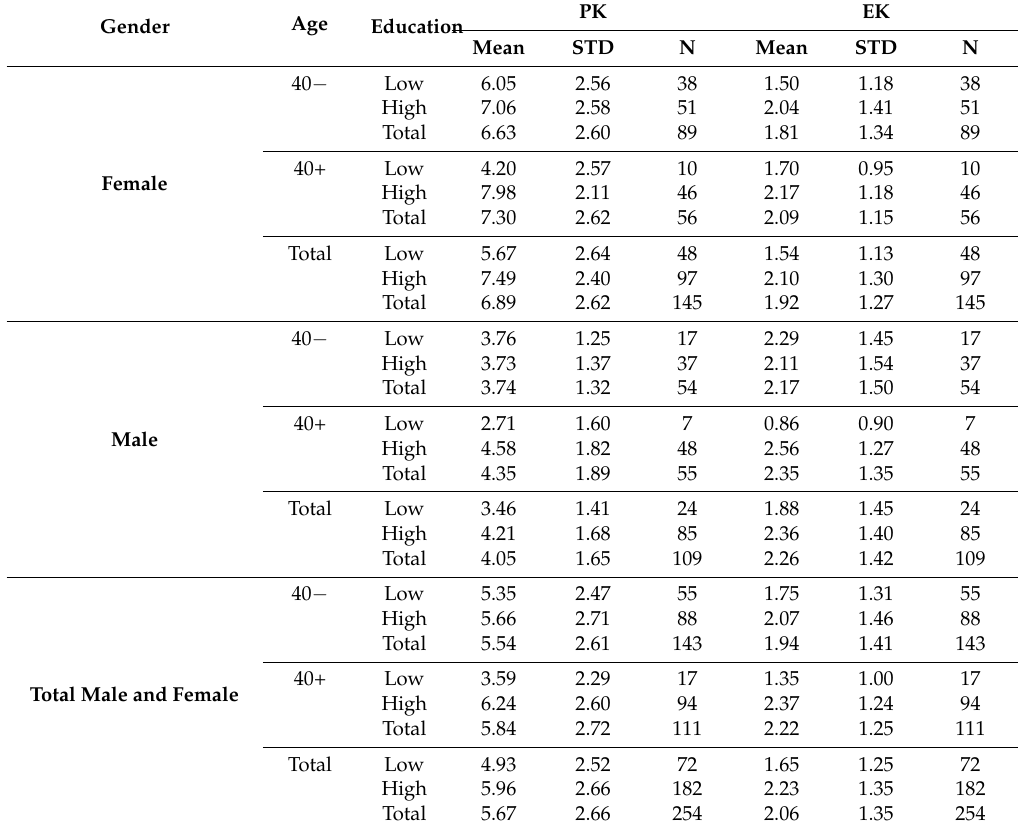
Table 2. Mean and standard deviation (STD) of plant knowledge (PK) score and